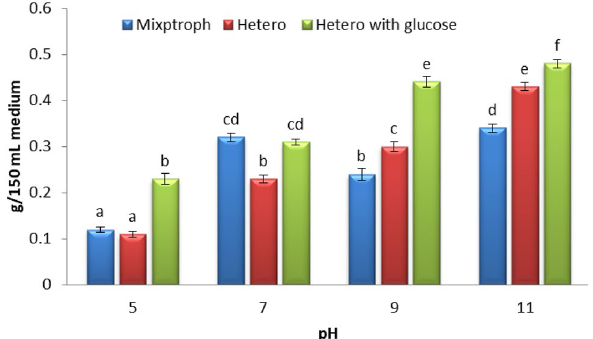
Figure 6. Effect of different pH levels on the dry weight of alga ( S. obliquus ) grown with the Disperse orange dye (20 ppm) under different growth conditions. Par represent standard error, different letters clear the significant result.